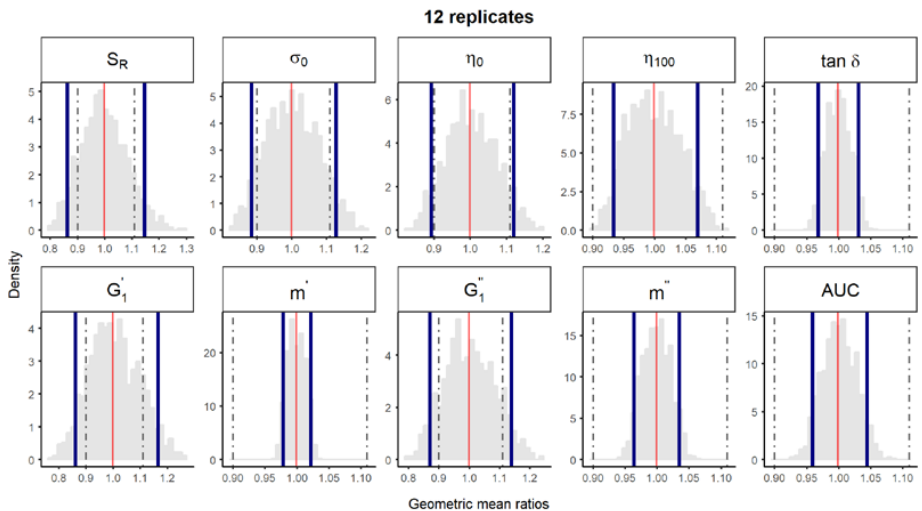
Figure 3. Bootstrap analysis of rheological parameters—five reference batches versus five reference batches. A total of 10,000 geometric mean ratios (light grey area) resulting from the bootstrap analysis of “5 reference batches versus five test batches” for each rheological parameter. Data of 10 batches and 12 replicate each were used. Median (solid red line) and non-parametric 90% CI (solid blue lines) of the probability distribution. Dashed lines represent the acceptance limits for equivalence (90%–111.11%) stated in the EMA guideline [4]. S R , relative thixotropic area; σ 0 , yield stress; η 0 , zero-shear viscosity; η 100 , viscosity at 100 s − 1 ; tan δ , loss tangent at 1 Hz; G (cid:48) , calculated elastic modulus; G (cid:48)(cid:48) , calculated viscous modulus; m’ and m ” are the parameters obtained when fitting G’ and G’’, respectively, versus frequency; AUC, area under the surface versus weight curve (spreadability).